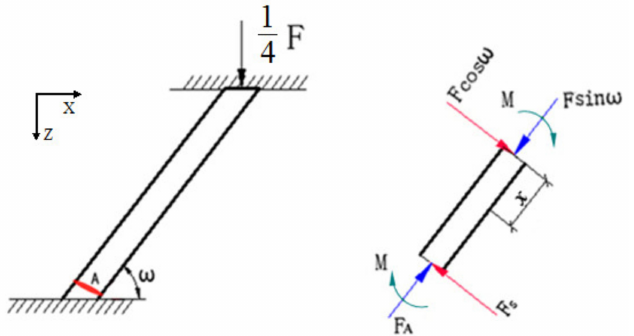
Figure 11. Force analysis of a single